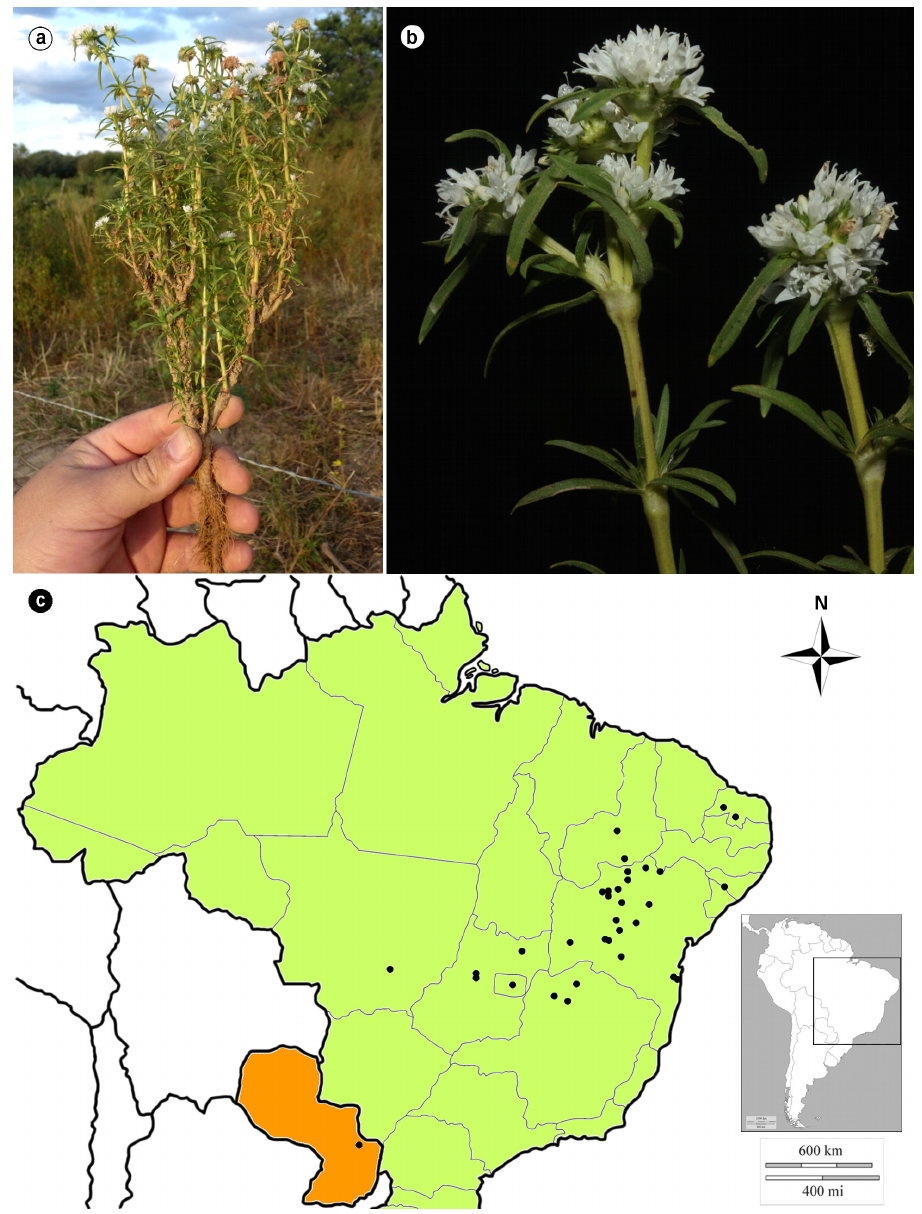
Figure 6 - Borreria diacrodonta . a . Habit; b . Detail of the inflorescence; c . Distribution map. (Photographs: R.M. Salas